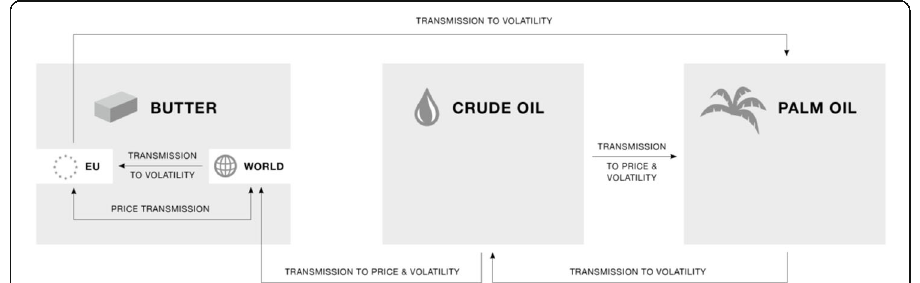
Fig. 11 Transmission effects between butter, palm oil and crude oil for the second